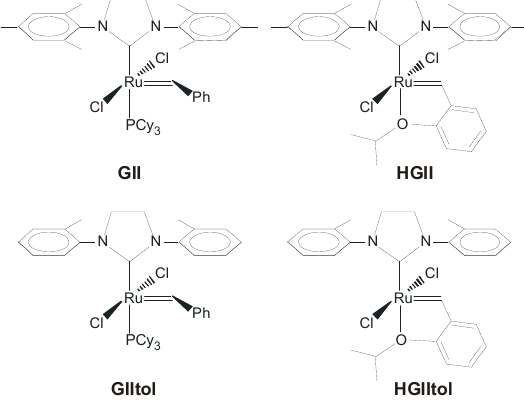
Figure 1. Commercial Grubbs’ and Hoveyda-Grubbs’ second generation catalysts.